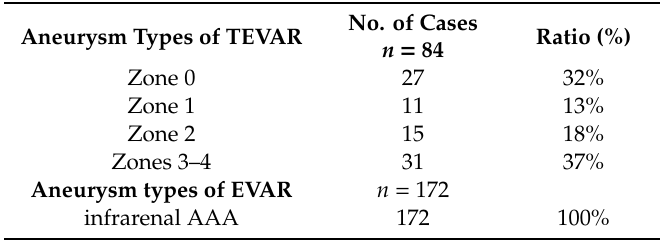
Table 2. Summary of data from the TEVAR and EVAR patients. The aneurysms were located in all four zones (thus zones 1–4) in TEVAR patients, but only one type of infrarenal abdominal aortic aneurysm was treated via